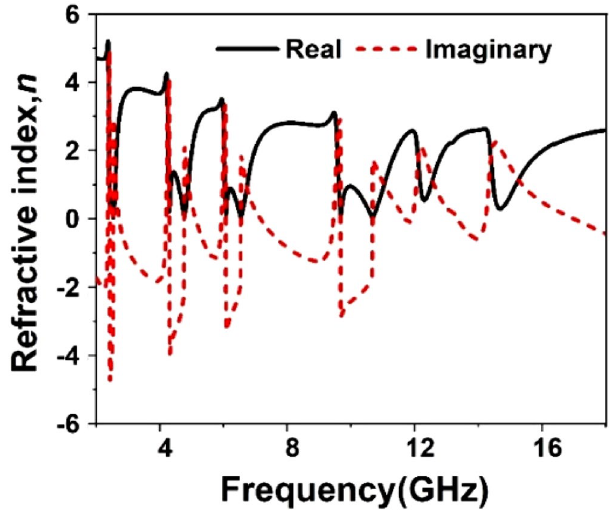
Figure 22. Refractive index, n of the unit cell.